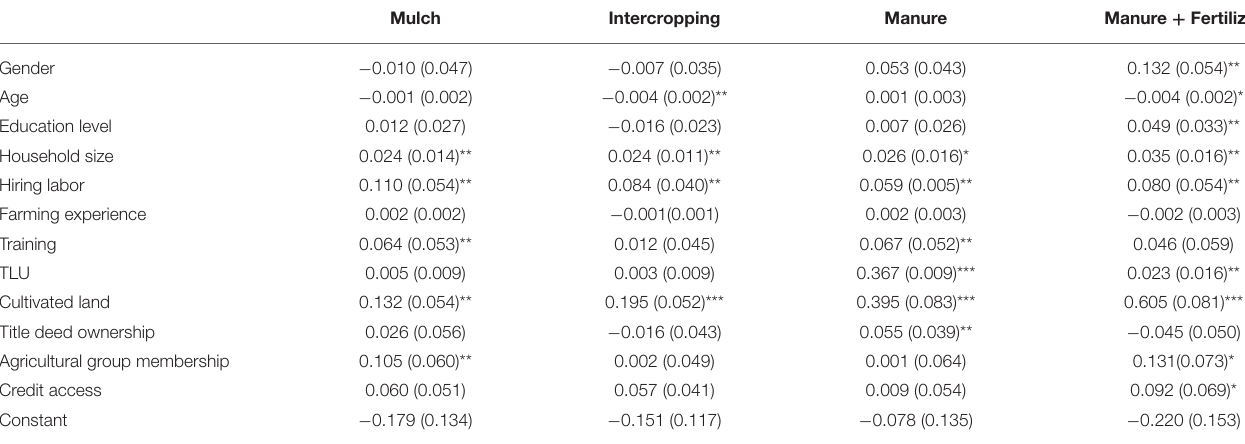
TABLE 7 | Parameter estimates of the Tobit model for the determinants of adoption intensity of the selected organic-based technologies in Murang’ a County. Mulch Intercropping Manure Manure +